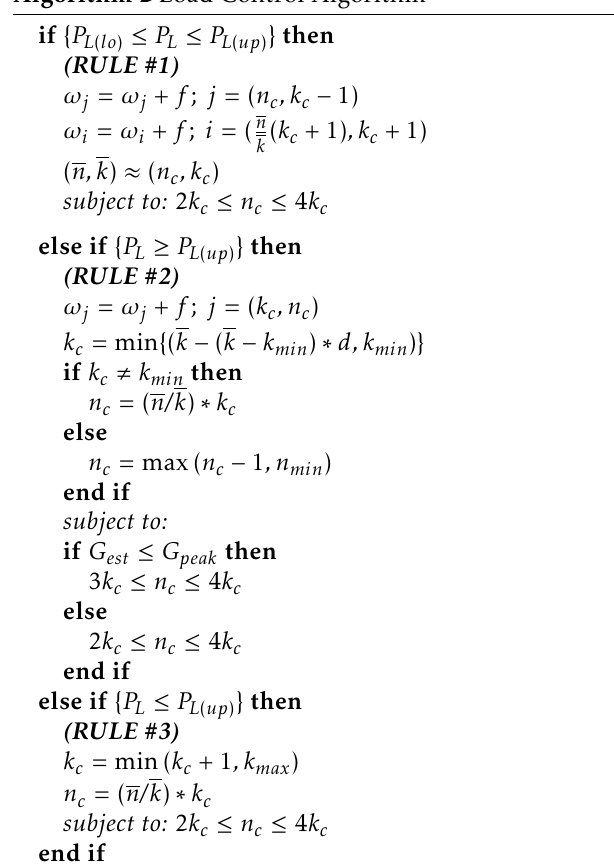
Algorithm 2 Load Control Algorithm